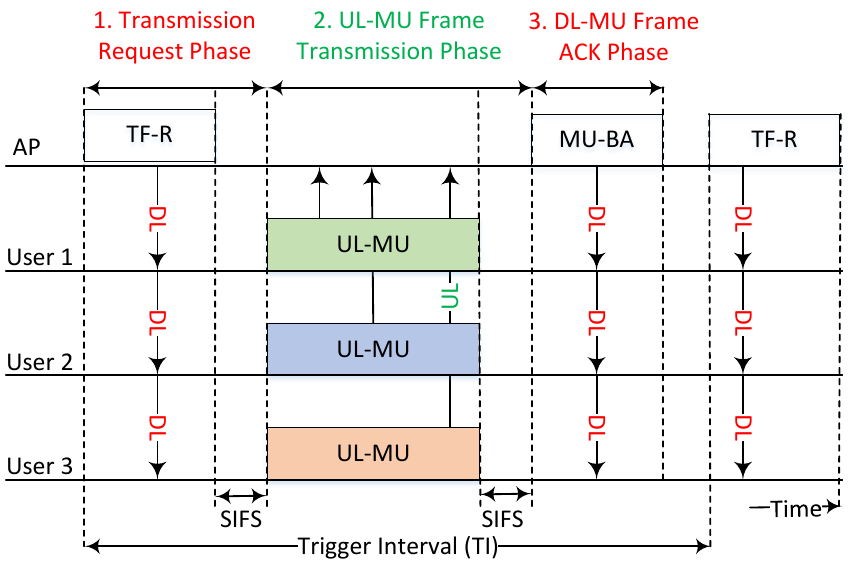
Figure 2. Trigger-based UL multi-user transmission sequence in IEEE 802.11ax